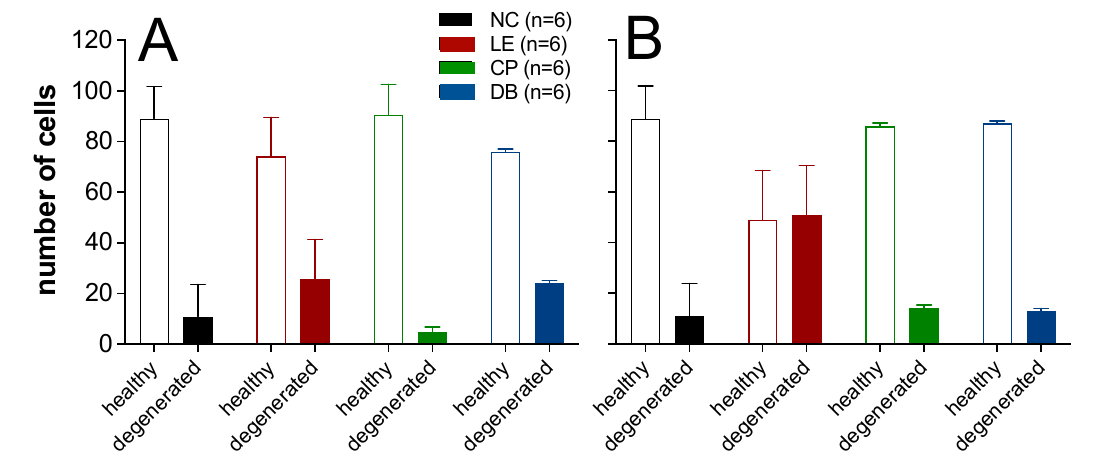
Figure 5. ( A ) Comparison of the healthy and degenerated CA1 and ( B ) CA3 neurons. Data for n = 6 animals from each group are shown as the mean ± SD for healthy and degenerated neurons.